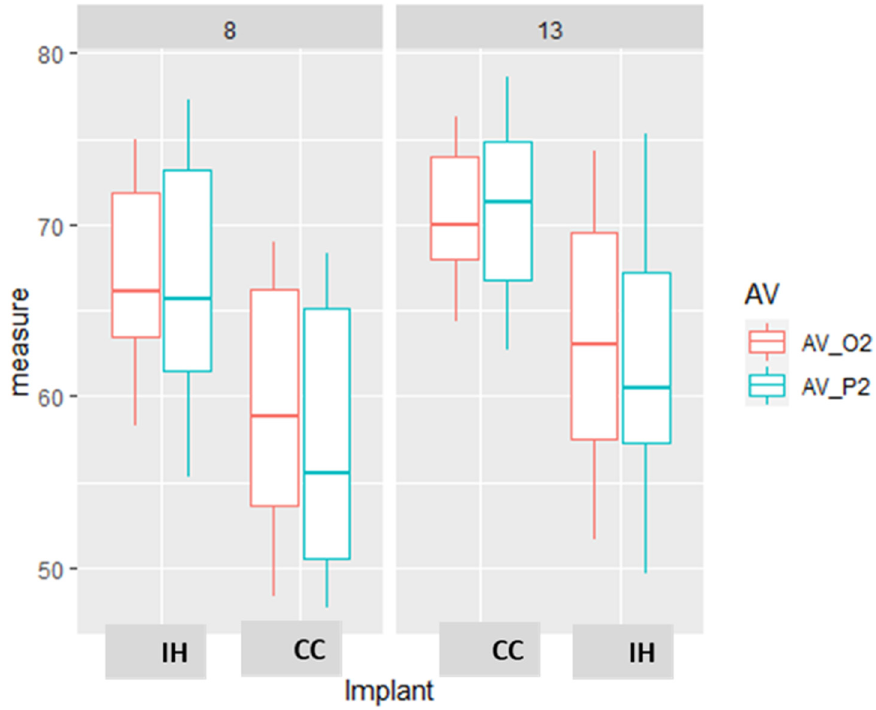
Figure 5. Box and whiskers plot of RFA measurements of Osstell (O2) and Penguin (P2) in CC or IH implant design, with different implant length (8 or 13 mm). The box represents the interquartile range and the median, and the whiskers represent the SD. Table 4. The difference of average implant stability measurements between the combined tested parameters of CC or IH implant design and implant length as measured by IT, Osstell (O2) and Penguin (P2) devices.